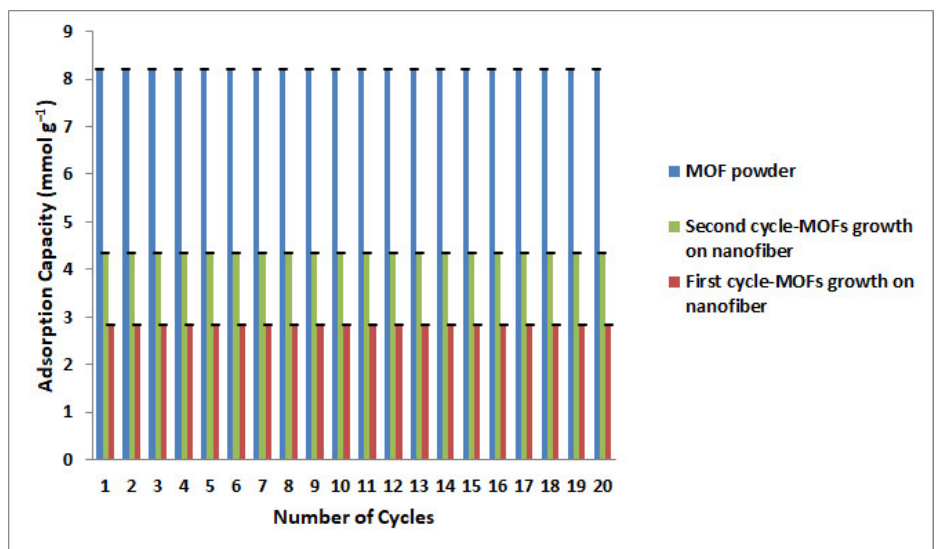
Figure 15. CO 2 cyclic adsorption capacities of the first cycle—MOFs growth, the second cycle—MOFs growth and MOF powder at 25 °C and 7 bar.